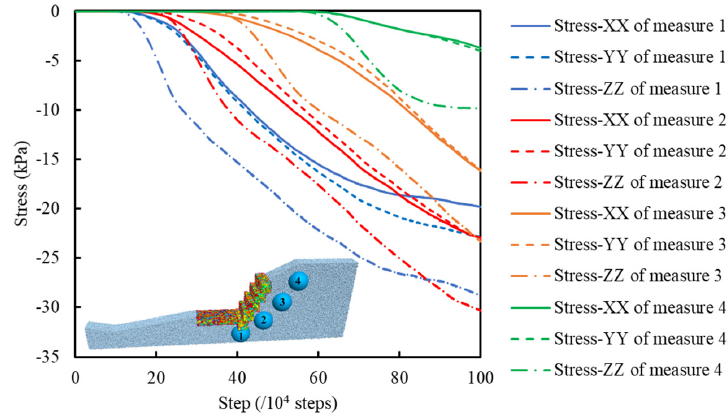
Figure 21. Curve of measured stresses.